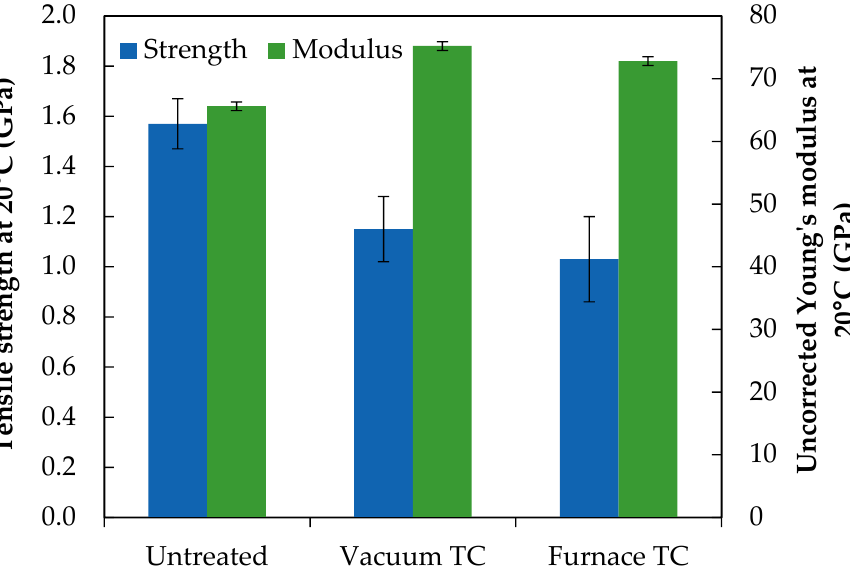
Figure 4. Average tensile properties of bare E-glass: Untreated, thermally conditioned (TC) under vacuum or thermally conditioned in an air furnace.